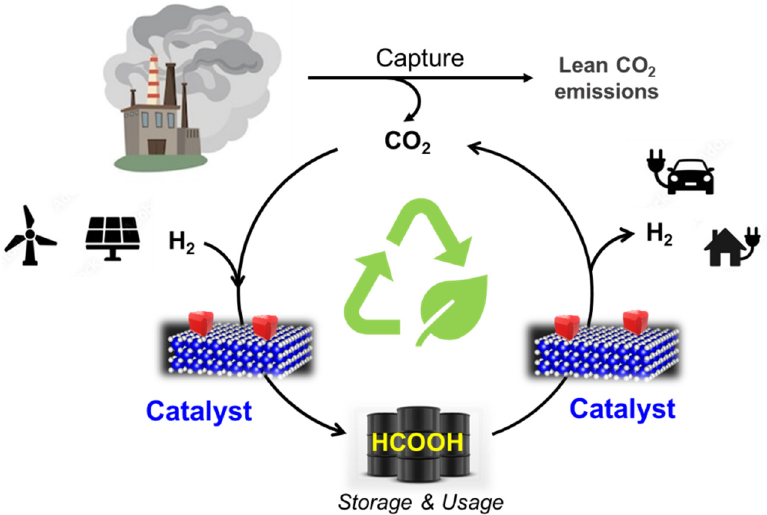
Figure 7. Hydrogenation/dehydrogenation cycle established by using formic acid as a liquid organic hydrogen carrier (LOHC).